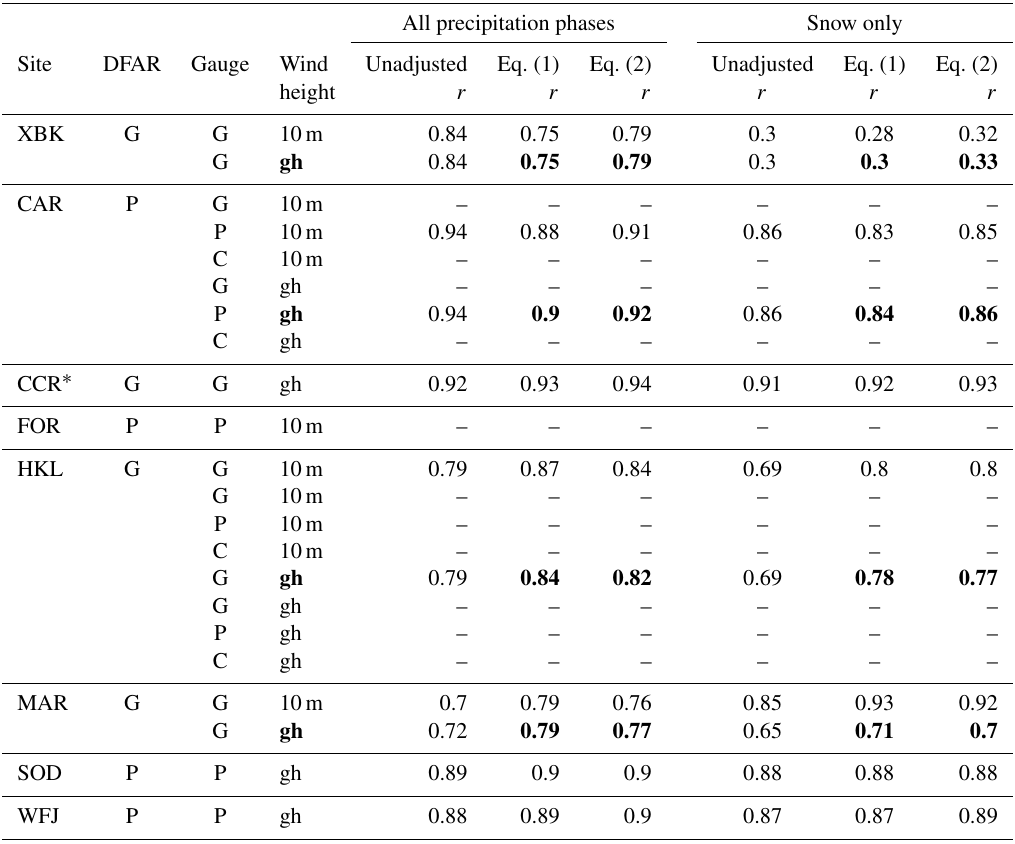
Table 7. Pearson correlation ( r ) for the unshielded gauges (G – Geonor; P – Pluvio 2 ) as compared to the DFAR reference at each site for the combined winters of 2015/2016 and 2016/2017 for available wind speed measurement heights (10m; gh – gauge height) and for Eqs. (1) and (2). Metrics are separated by precipitation phase (all and snow only). Where both wind speed heights are available, the gauge height data are shown in